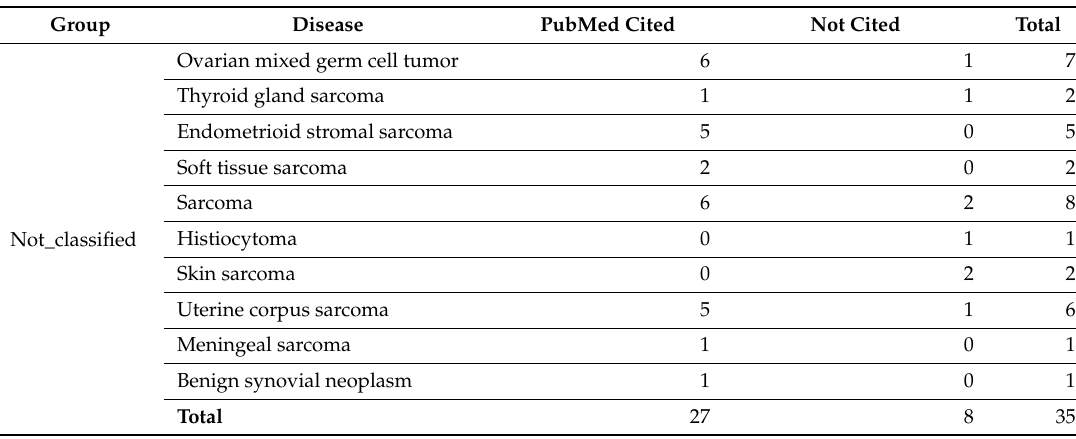
Table 6. PubMed citation of cell lines with histology unclassified by